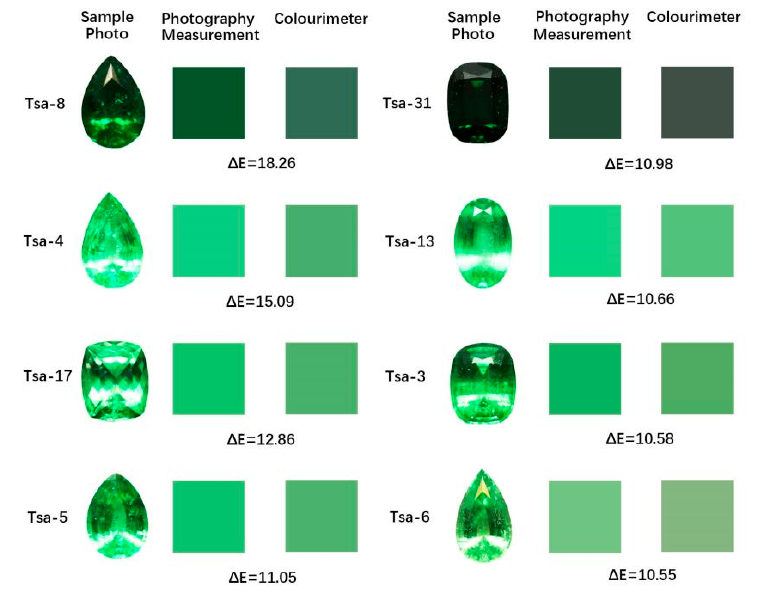
Figure 7. Simulated color blocks were used to more clearly illustrate the color discrepancy between photography data and the colorimeter result.